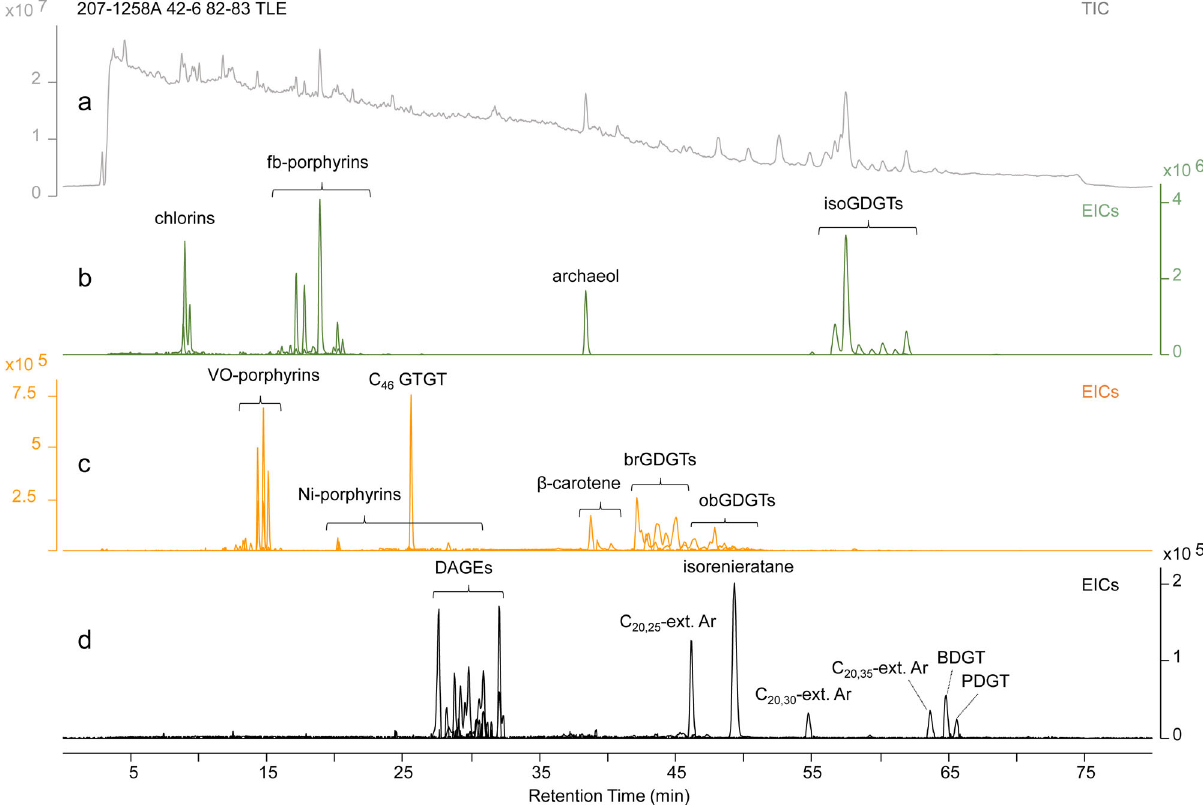
Fig. 1 Total ion chromatogram (TIC) and summed extracted ion chromatograms (EIC) from LC-qTOF-MS analysis for sample 1258A 42-6 82-83. a TIC depicting the overall signal intensity of major biomarkers and background metrics. b – d Combined EICs based on the relative abundance of targeted biomarker classes to show compound separation and abundance. Extracted m/z values based on theoretical exact masses of adduct ions: